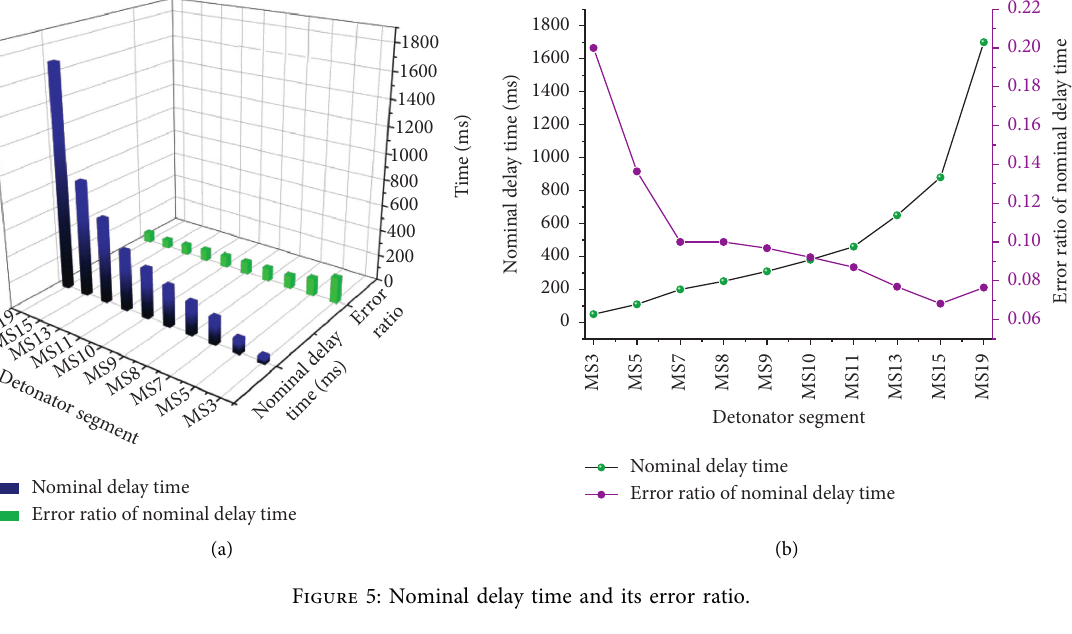
Figure 5: Nominal delay time and its error ratio.